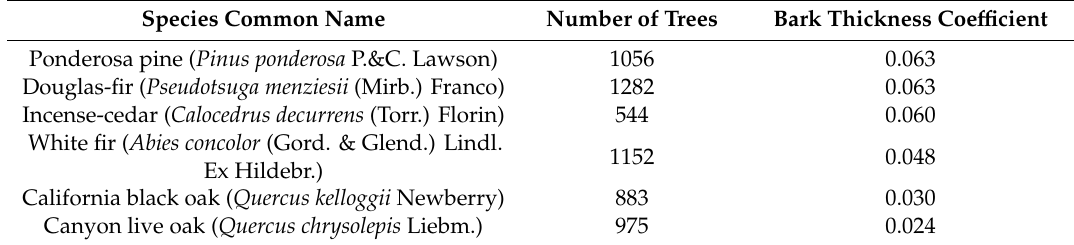
Table 4. Tree species coding and number of pre-fire live trees included in the fire-e ff ects analysis. Bark thickness multiplier taken from